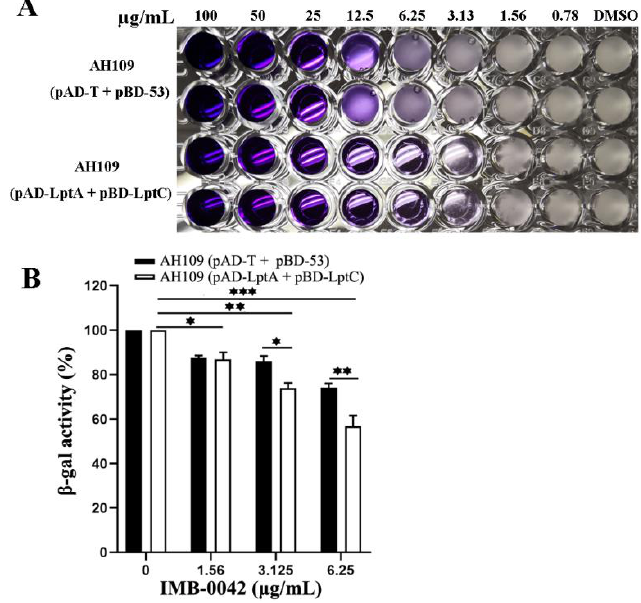
The MIC of IMB-0042 against AH109 (pAD-LptA+pBD-LptC) cells was 3.125 µg/mL,